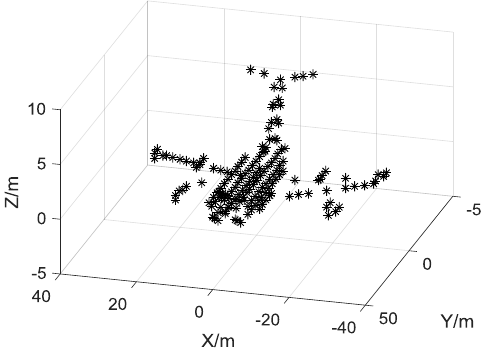
Figure 10. The model of experiment.